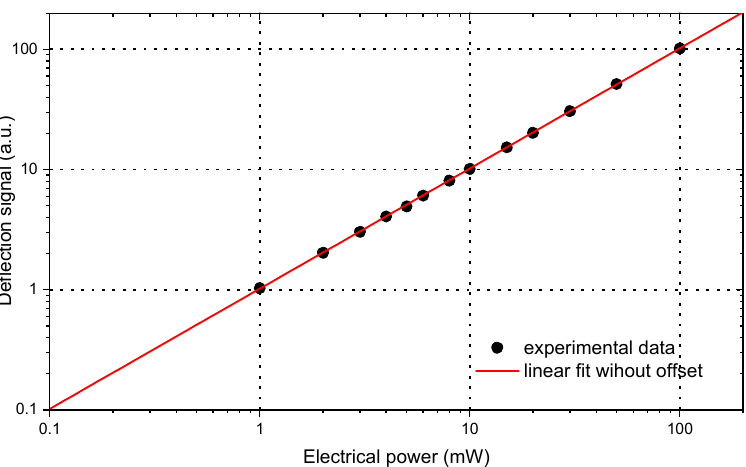
Figure 4. Measured deflection signal as a function of the electrical power (dots) and the linear fit without offset (red line) used for a determination of the calibration coefficient.